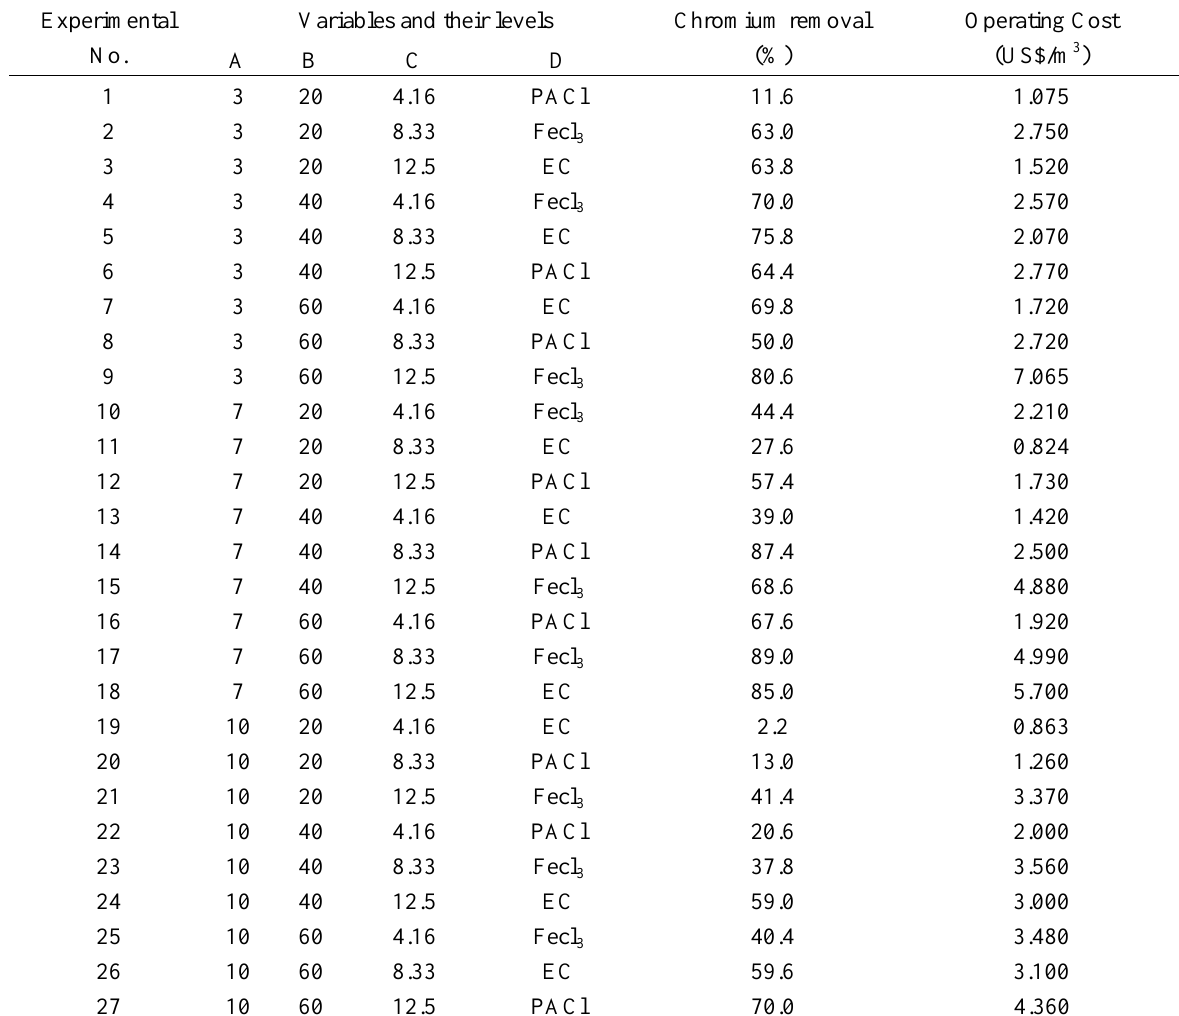
Table 3. Observed results of experiments corresponding to Taguchi design.